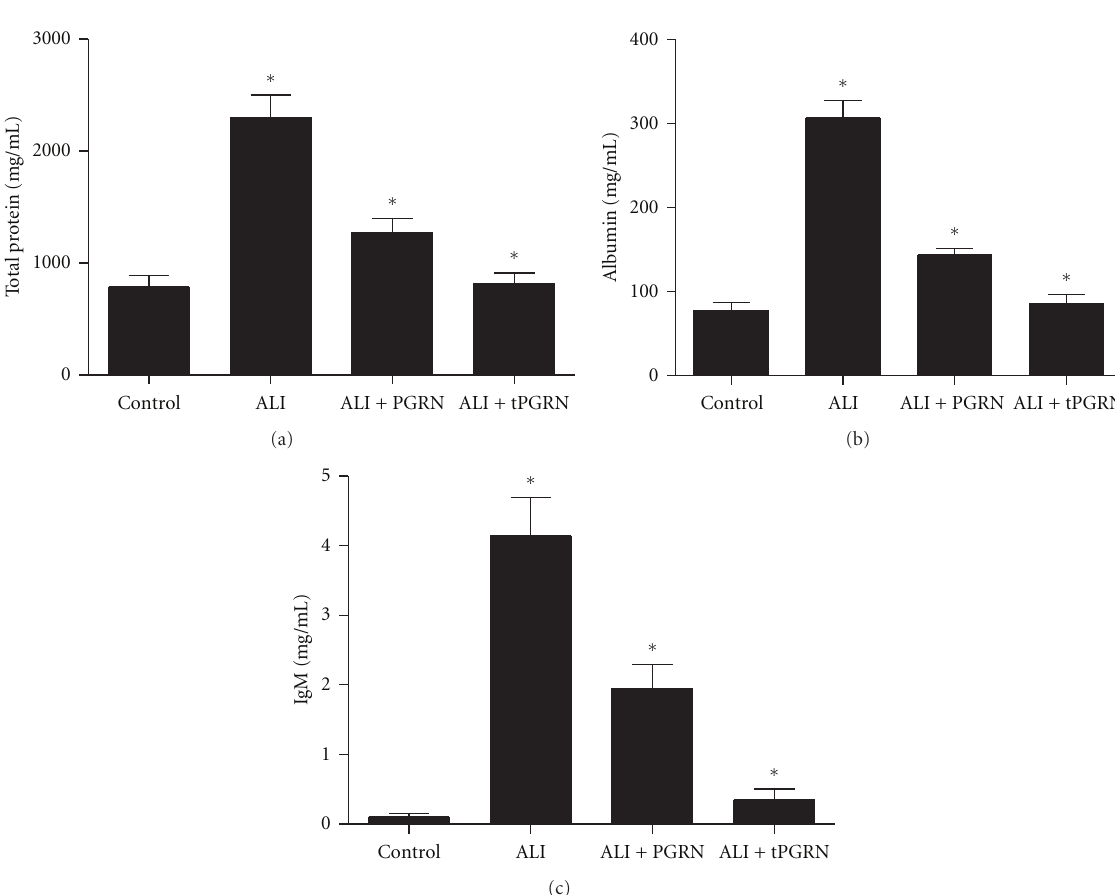
Figure 4: Administration of PGRN reduced the LPS-induced lung permeability. Groups of mice were treated as described above and then the total protein (a), albumin (b), and IgM (c) in BAL fluid were determined at day 3 after LPS challenge. Data are represented as mean ± standard deviation of one experiment consisting of three replicates. Experiments were performed in triplicate. ∗ P < 0 . 05.